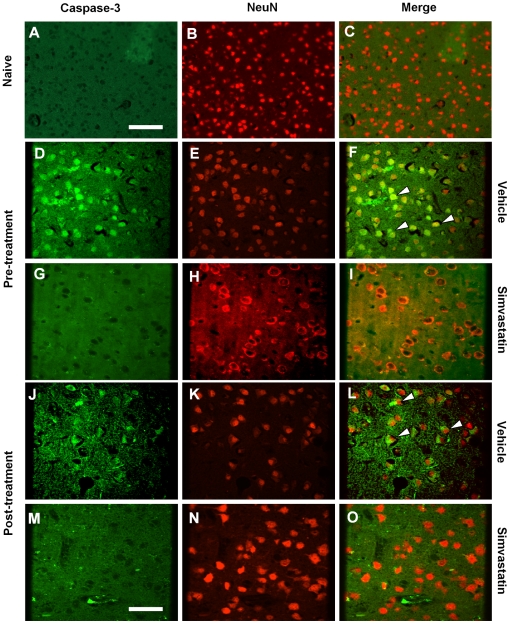
Simvastatin reduces caspase-3/NeuN positive cells after SAH.Representative images shown are from cerebral cortex. Vehicle treated animals show numerous caspase-3/NeuN positive cells (F and L, arrow heads). In comparison, there are fewer positive cells in post-SAH simvastatin treated animals (O), and almost no positive caspase-3/NeuN positive cells in the pre-treatment mice (I), none in naïve mice (C). Scale bars are 100 µm in A to C, 50 µm in D to O.